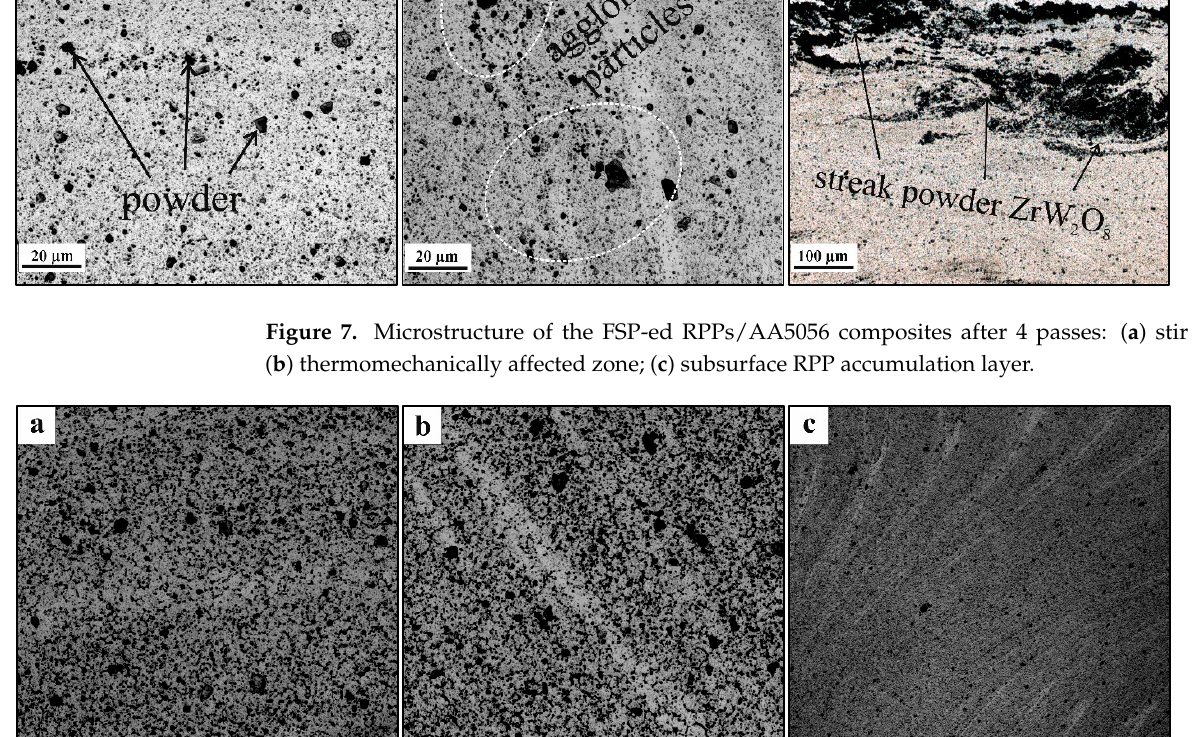
Figure 7. Microstructure of the FSP-ed RPPs/AA5056 composites after 4 passes: ( a ) stir zone, ( b ) thermomechanically affected zone; ( c ) subsurface RPP accumulation layer.